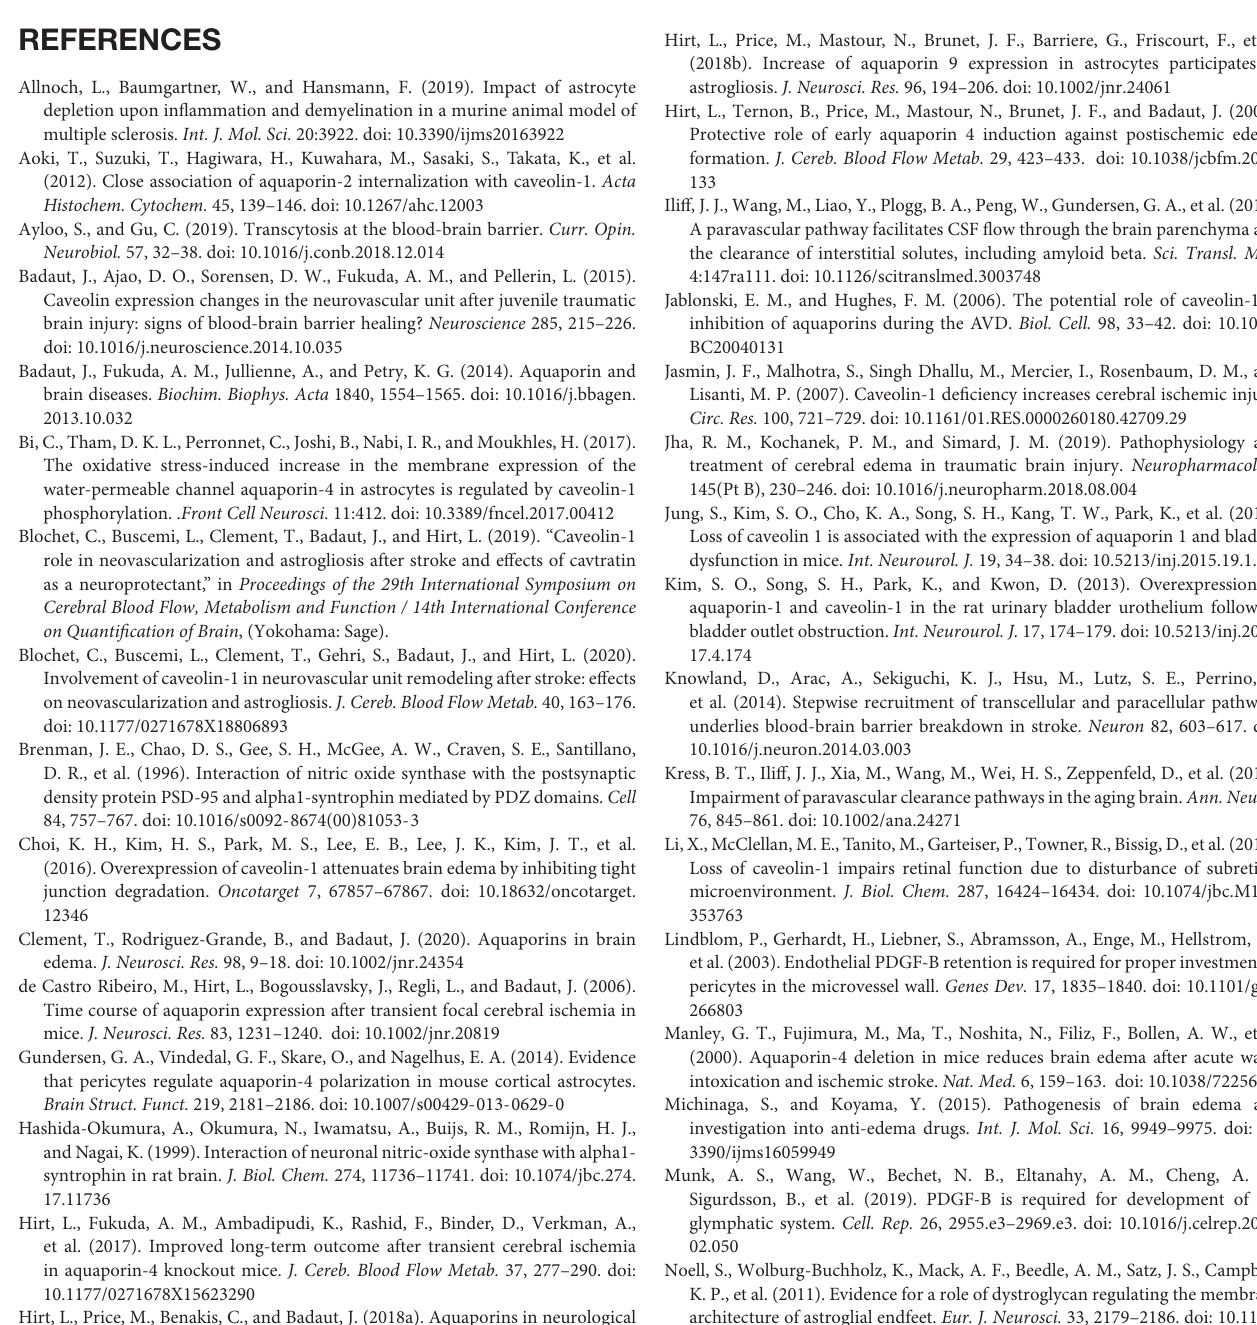
bar = 20 µ m. (B) Single-channel confocal microscopy ROIs obtained from 40 × magnification images, illustrating the overview of GS-positive astrocyte morphology and skeletonization. (C) Number of GS-positive astrocytes. WT-Ipsi compared to WT-Contra: 95% CI [ − 18.54 to − 1.904], p = 0.0081, and WT-Ipsi compared to KO-Ipsi: 95% CI [6.348 to 22.99], p < 0.0001. (D) Ramification of GS-positive astrocytes assessed by the number of quadruple points